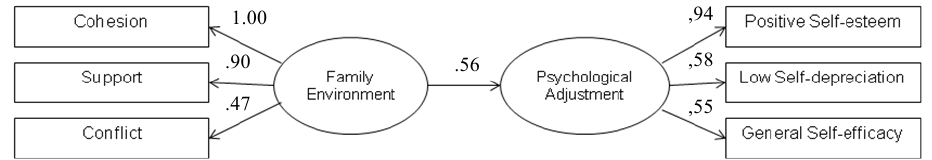
Figure 1 . Structural model representing the association between family environment and psychological adaptation. The parameters shown are standardized regression weights with p